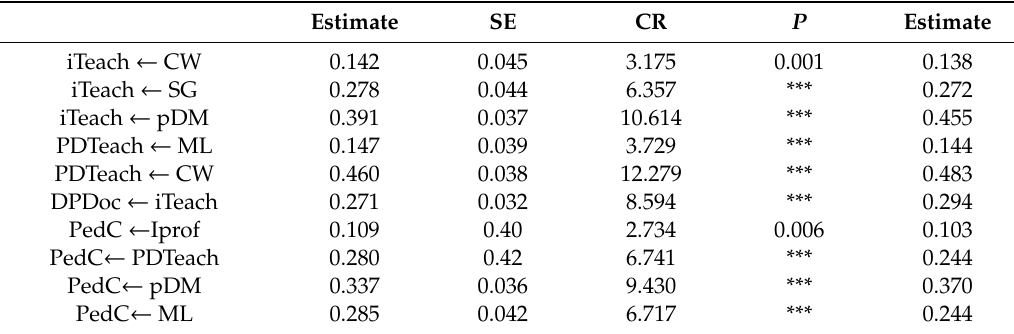
Table 3. Standardised regression